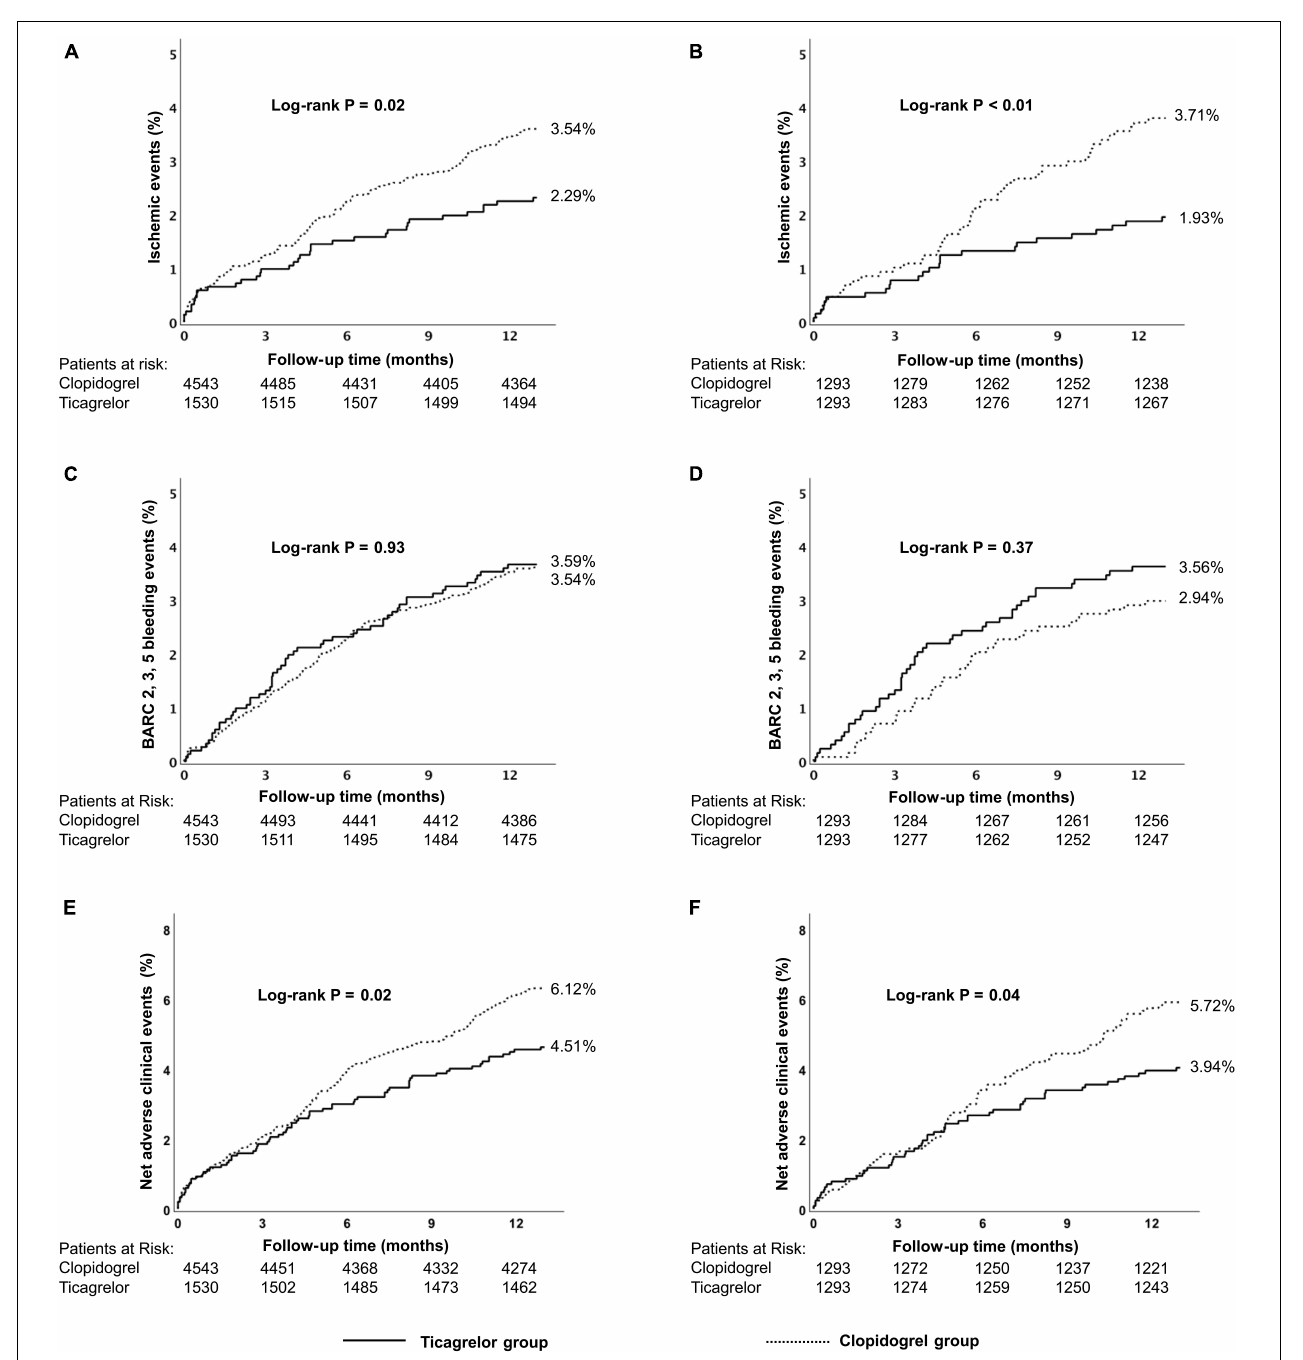
FIGURE 2 | Kaplan–Meier cumulative event curves for a 12-month period for patients treated with ticagrelor or clopidogrel in the high-risk group, including primary endpoints ischemic events (A,B) BARC 2, 3, 5 bleeding (C,D) and net adverse clinical events (NACEs) (E,F) . Before propensity score matching (A,C,E) ; after propensity score matching (B,D,F) . Ischemic events, defined as a composite of cardiac death, myocardial infarction (MI), and stroke.Net adverse clinical events, defined as a composite of all-cause death, myocardial infarction, stroke, and BARC type 3, 5 bleeding events. BARC, Bleeding Academic Research